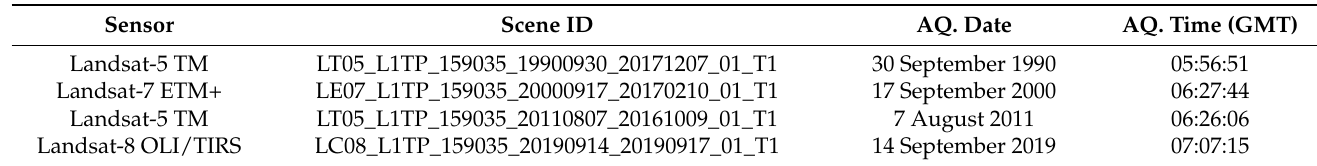
Table 1. The information about the Landsat datasets used to obtain Mashhad LU/LC and LST maps. Sensor Scene ID